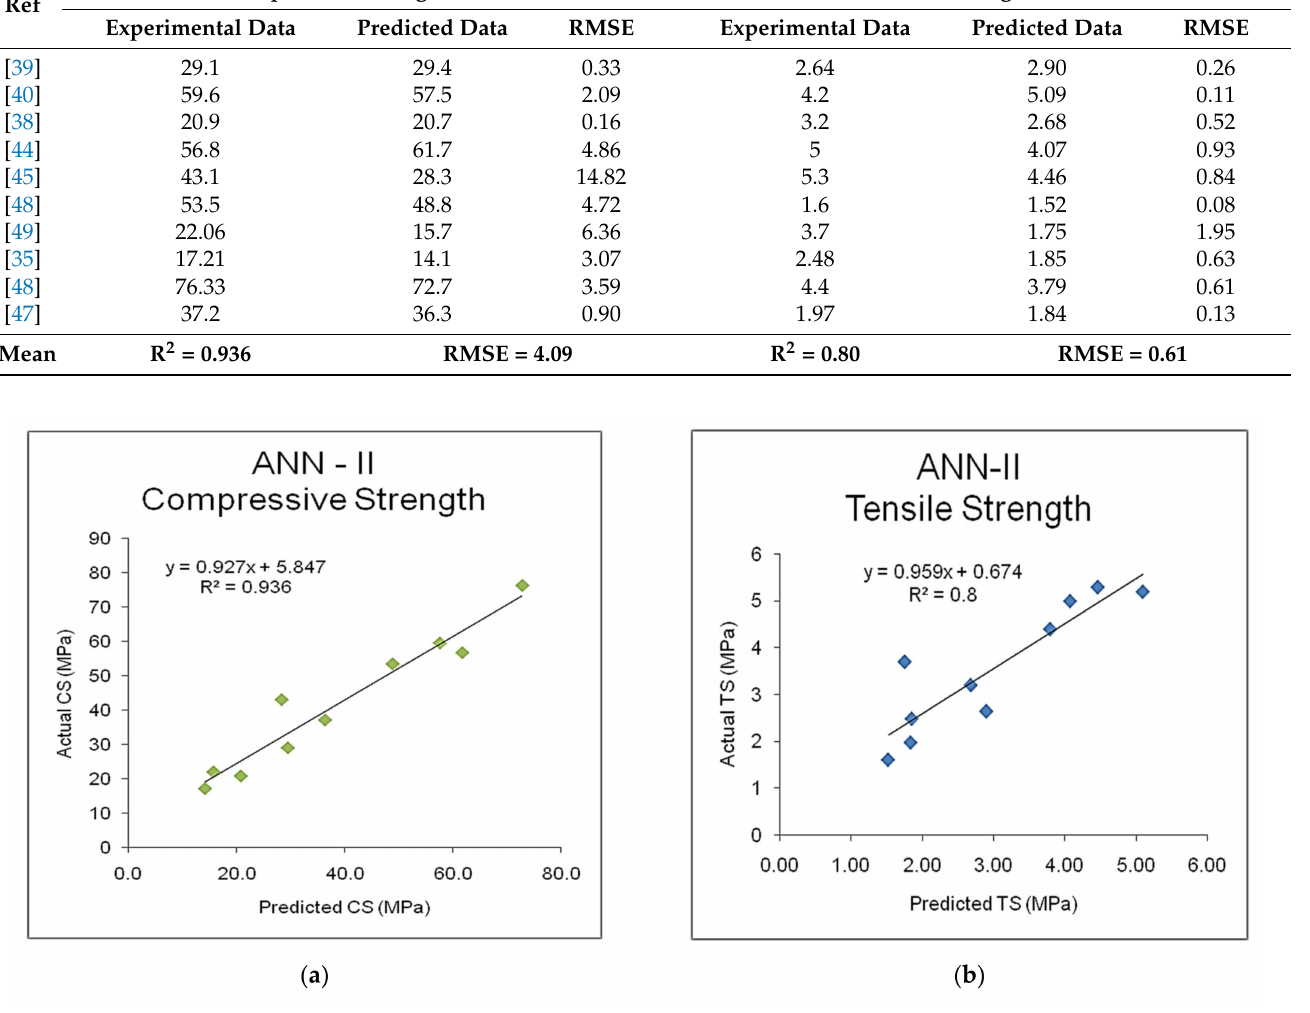
Figure 6. Regression analysis of ( a ) compressive strength (CS) and ( b ) tensile strength (TS) of ANN- II